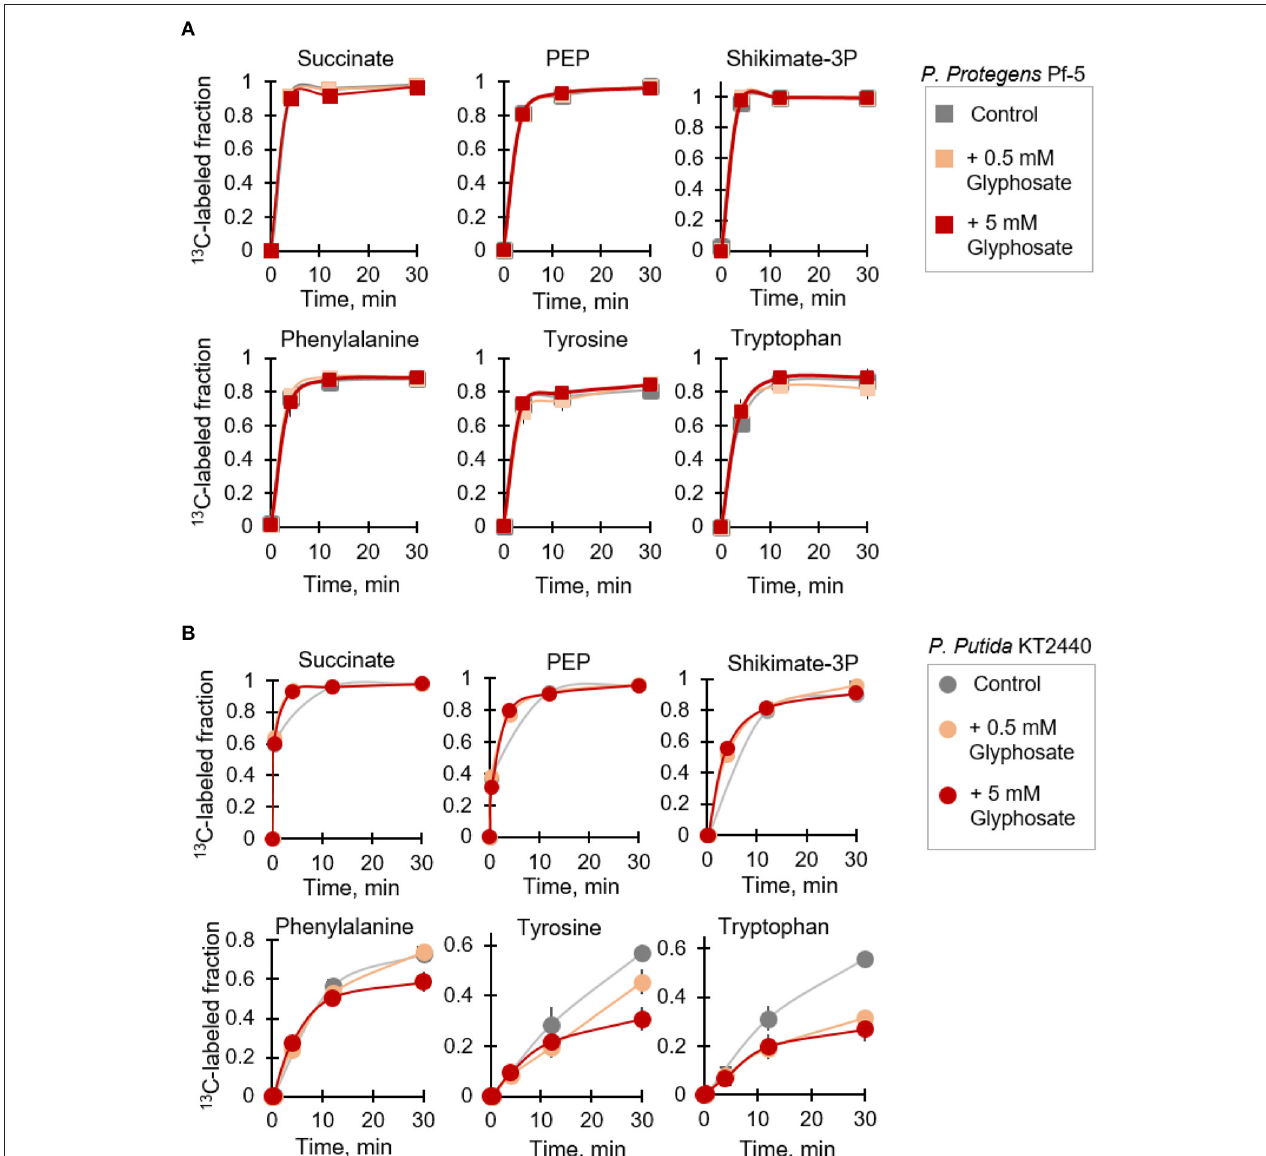
FIGURE 5 | Kinetic isotopic profiling of the shikimate pathway of glyphosate-exposed Pseudomonas species. Dynamic biosynthesis of fully-labeled fractions of metabolites in P. protegens Pf-5 (A) and P. putida KT2440 (B) following isotopic switch from unlabeled succinate to 13 C-labeled substrate in the absence (control) or in the presence of glyphosate (at 0.5mM or 5mM). The data (average ± standard deviation) are from independent biological replicates ( n = 3). Error bars are not visible when they are very small. Compared to the labeling kinetics in the control experiment, the labeling fraction of the aromatic amino acids at 30-min in the P. putida KT2440 cells at the high-glyphosate concentration was statistically-significant ( p < 0.05).